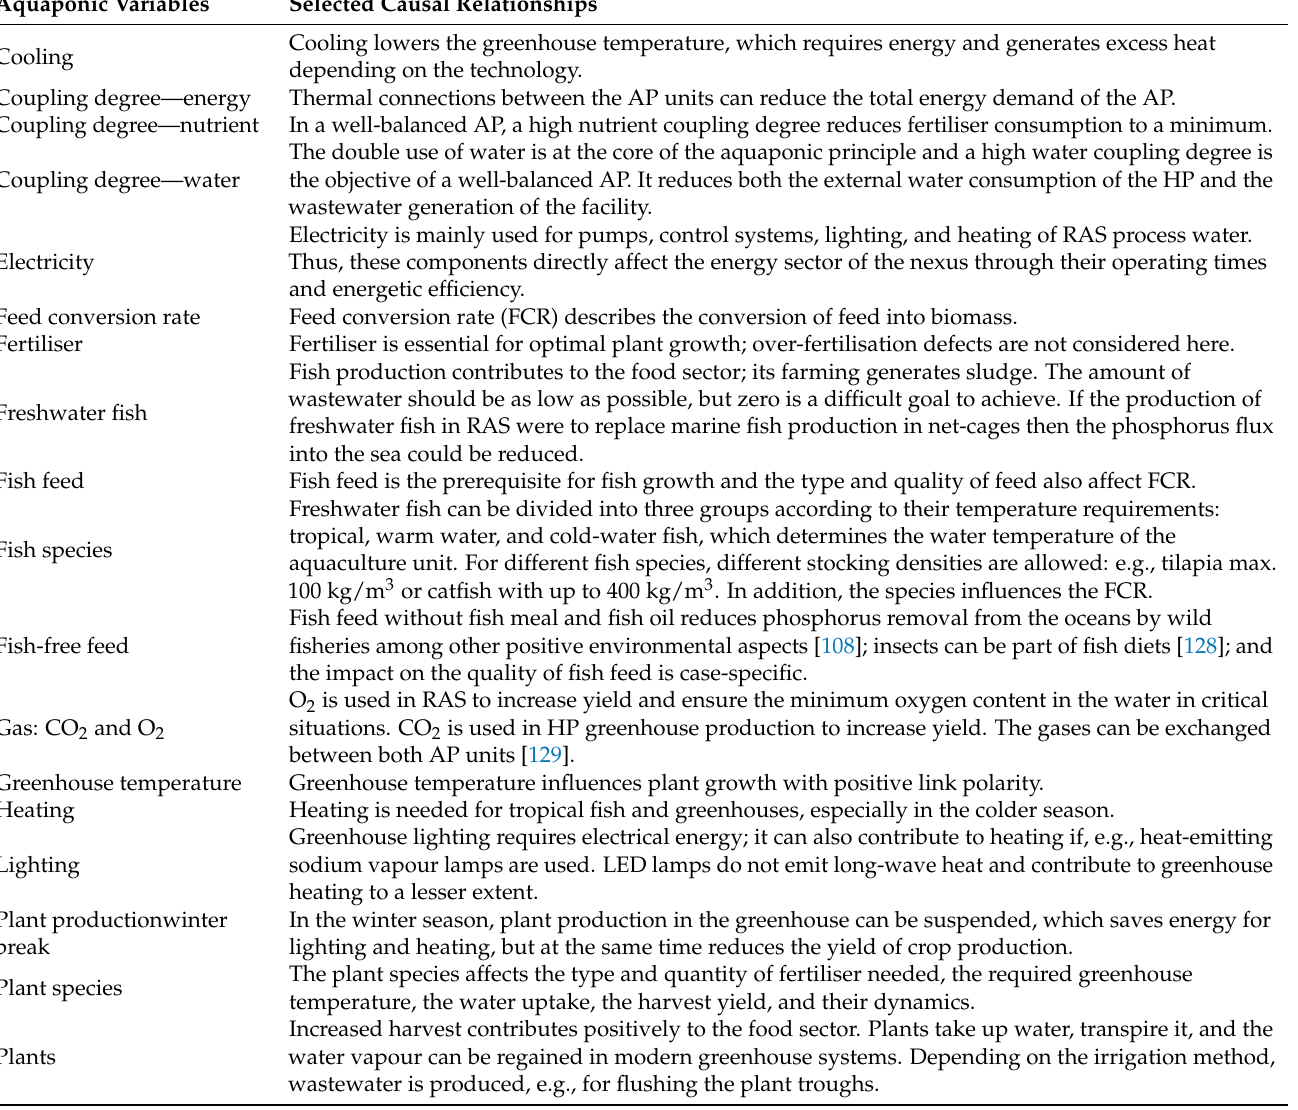
Table A1. Causal relations of significant aquaponic